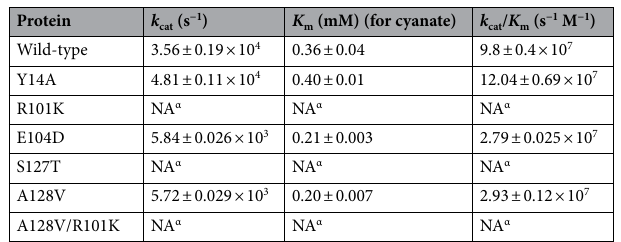
Table 2. Summary of kinetic data for wild-type and mutant cyanases. α No activity was observed under the same conditions.